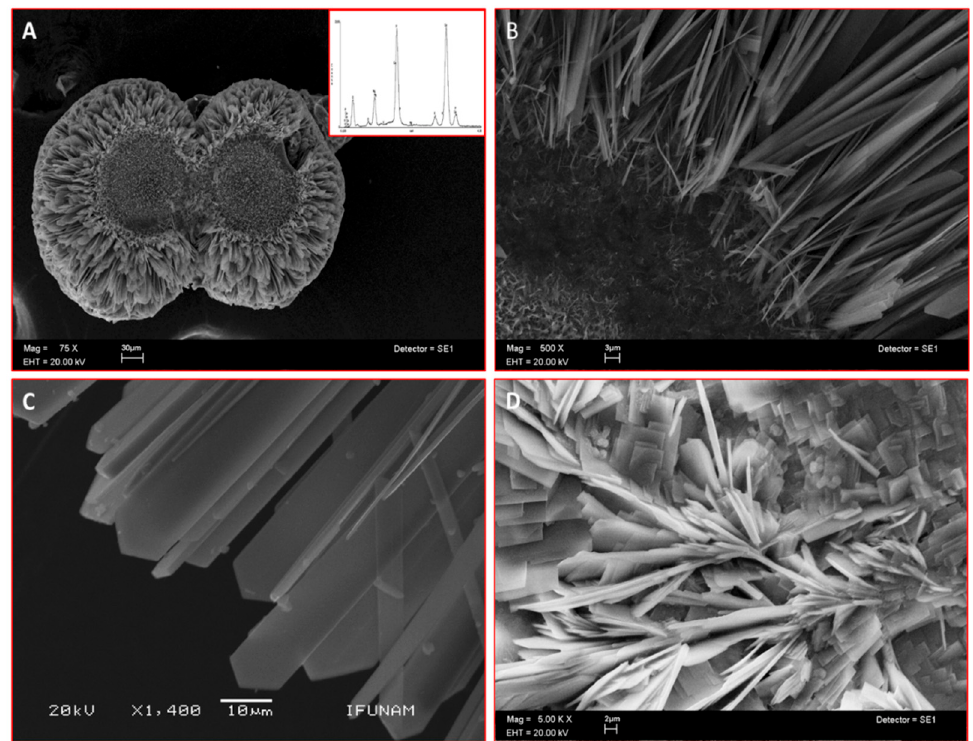
Figure 2. Scanning electron microscope (SEM) images of sphere-like structures formed in vitro by CEMP1-p4 (inset indicates Ca/P ratio of 1.52) ( A ). ( B ) Higher magnification shows an amorphous core with nascent needle-like crystals. ( C ) Hydroxyapatite crystals show a spear-like form. ( D ) Control crystals show irradiating crystals and plate-like crystals.